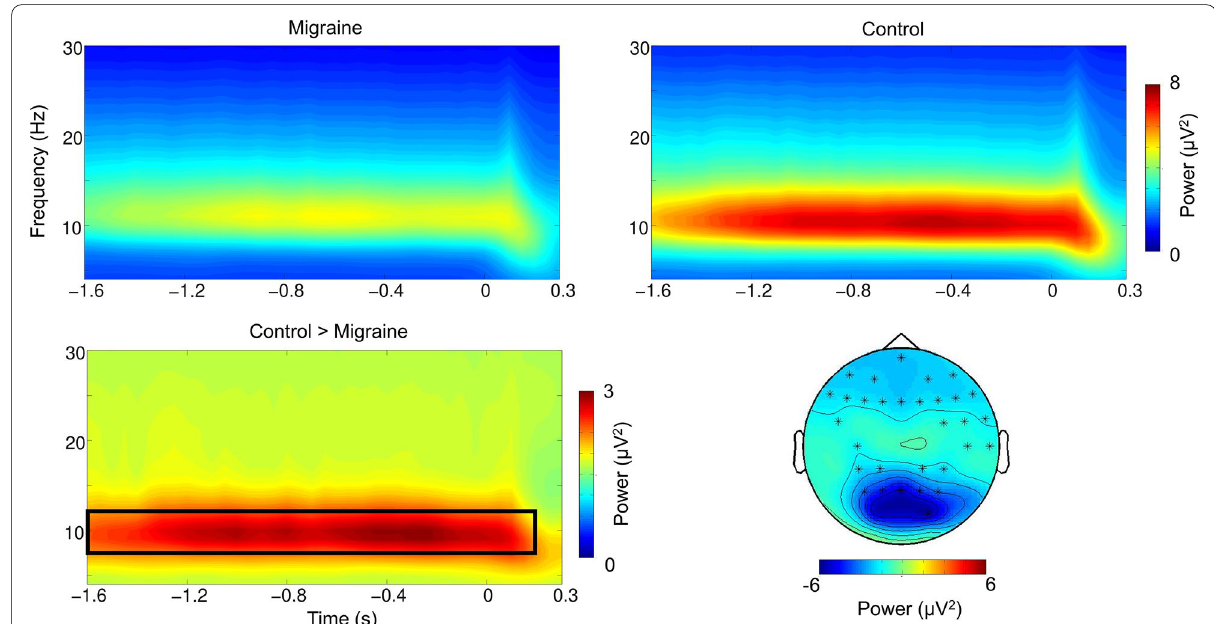
Fig. 3 Grand mean (collapsed across all electrodes) time-frequency representation of power and topography of the alpha-band power differences (migraine - control) for the highlighted interval. The electrodes with the maximum effect over the period [ asterisk